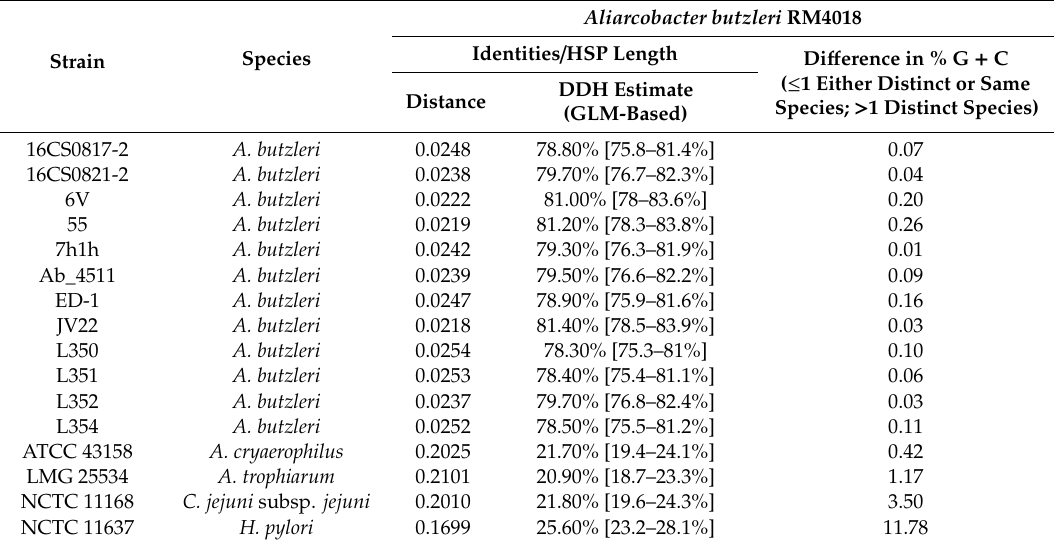
Table 3. Results of the in silico DNA–DNA hybridization (DDH).